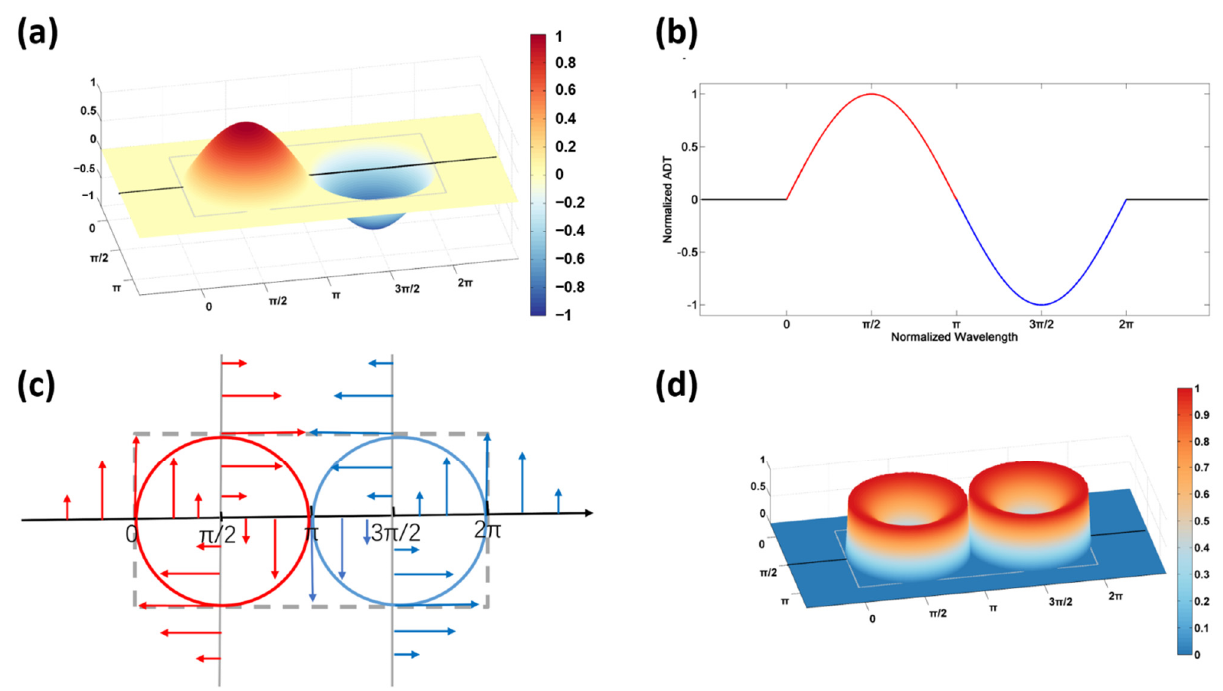
Figure 11. ( a ) Ideal ADT field, where the shaded color represents the normalized ADT; ( b ) ADT along the black line in a; ( c ) schematic of the geostrophic current field derived from the ADT field in a; and ( d ) normalized geostrophic velocity of ( c ), where the shaded color represents the normalized geostrophic velocity and the black line represents the position of the ADT in ( b ). Table 2. Eddy number statistics of